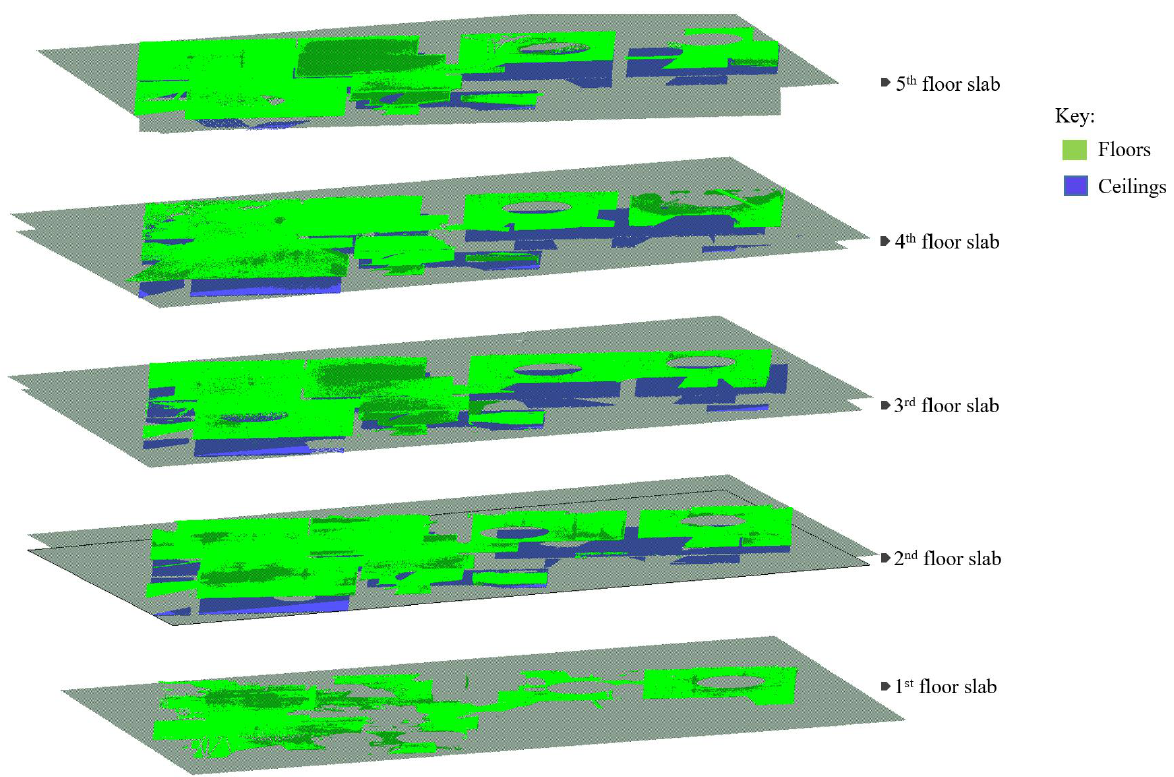
Figure 20. Floor slabs detected in the experiment are represented by the pairs of ceiling and floor planes.